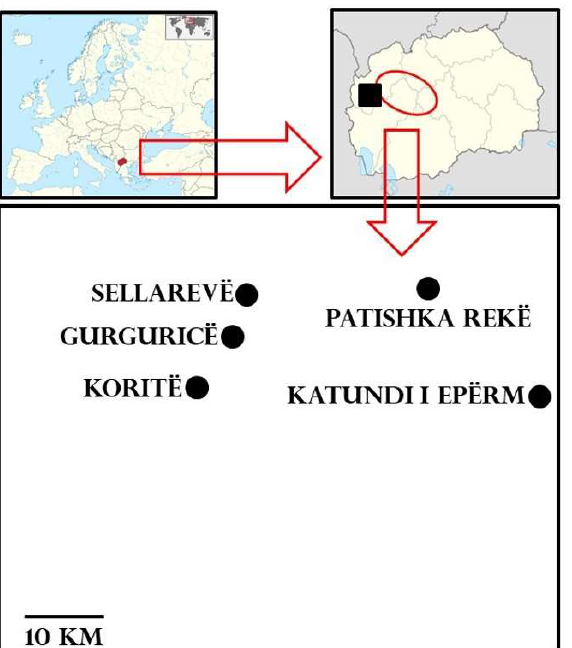
Figure 1. Map showing the location of the five Albanian study villages within North Macedonia (area circled in red) and the Reka Valley (black square), from where the villagers originated. The visited villages consisted of the following: